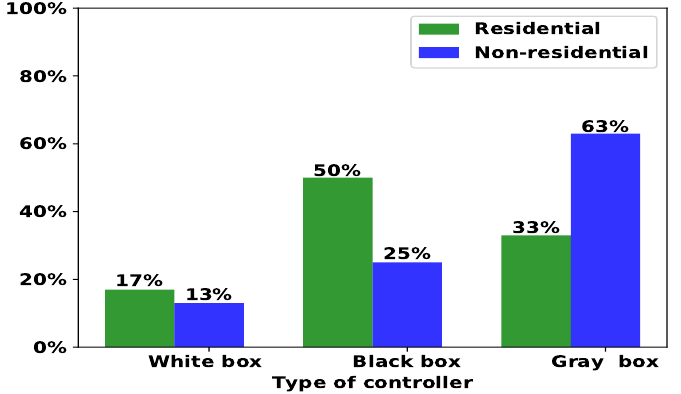
Figure 13. Controller used for renewable energy sources integration in non-residential and residential